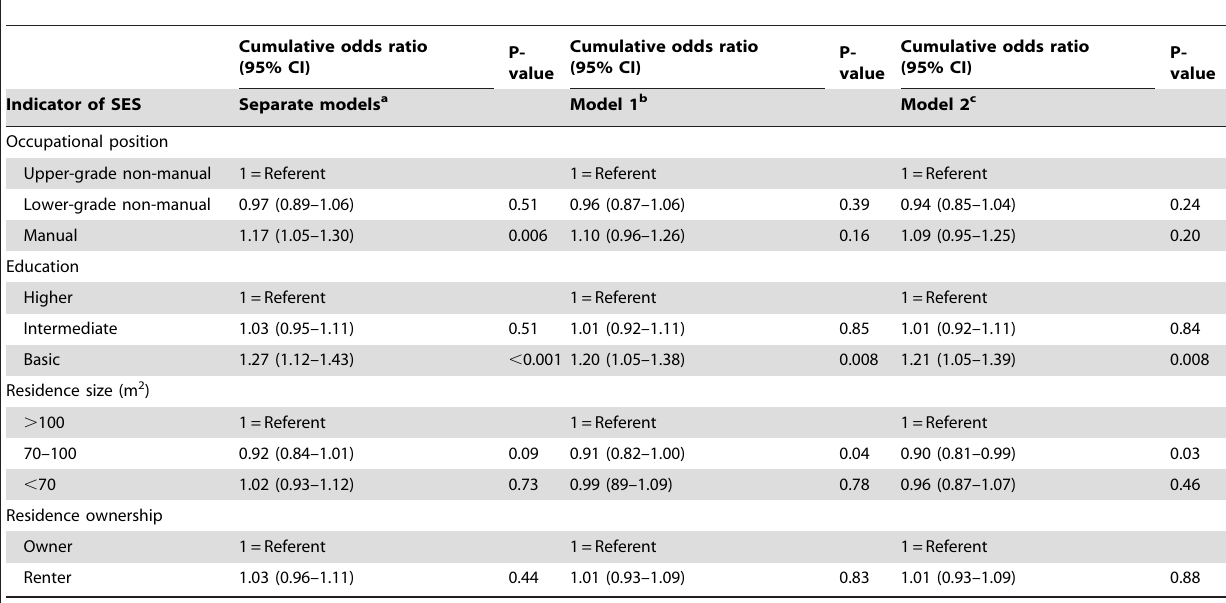
Table 3. Associations between indicators of socioeconomic status (SES) and length of work disability due to